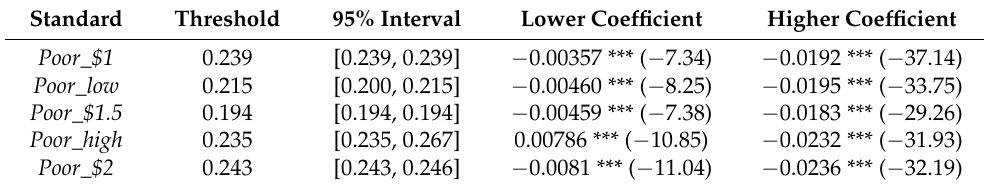
Table 19. Threshold estimates, confidence intervals, and coefficient changes.